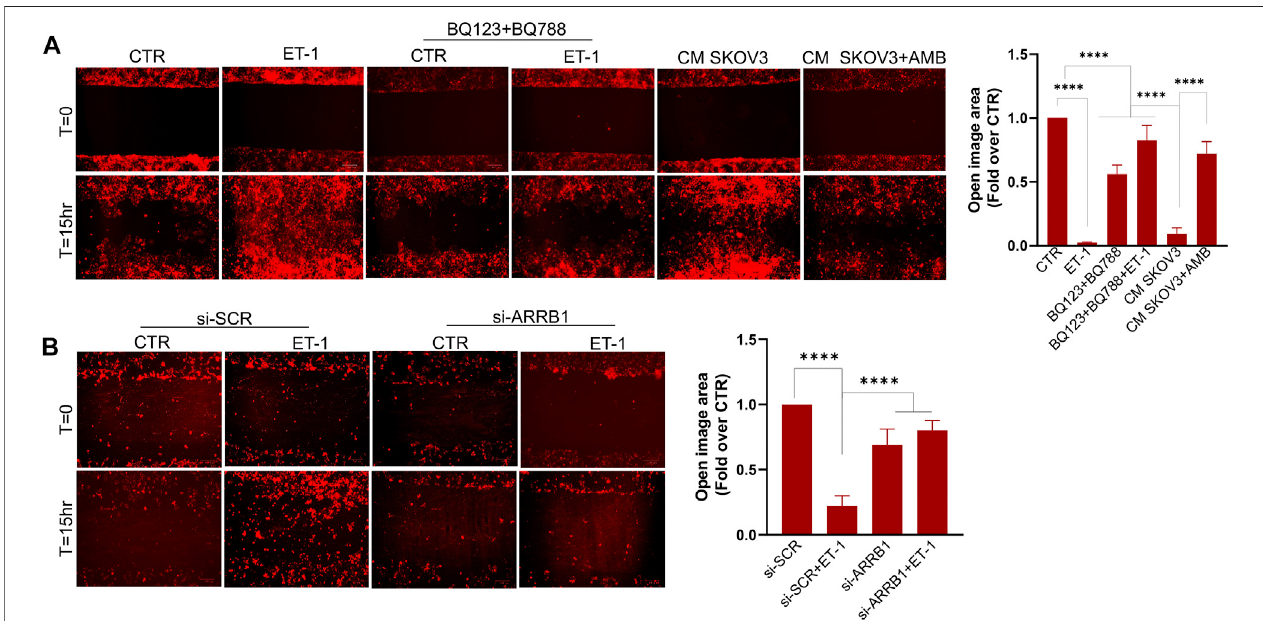
FIGURE7| ET-1promotesmigrationofMCsthroughtheET A R/ET B R/ β -arr1axis. (A) WoundhealingassayinMCsafteradditionofET-1and/orBQ123+BQ788or CMfromcontrolorAMB-treated SKOV3for15 h. (B) Wound healingassayinMCstransfectedwithsi-SCRandsi-ARRB1 andstimulated byET-1for15 h.Histograms, the mean ± SD, n (cid:2) 6. One-way ANOVA and shown as fold-over CTR.